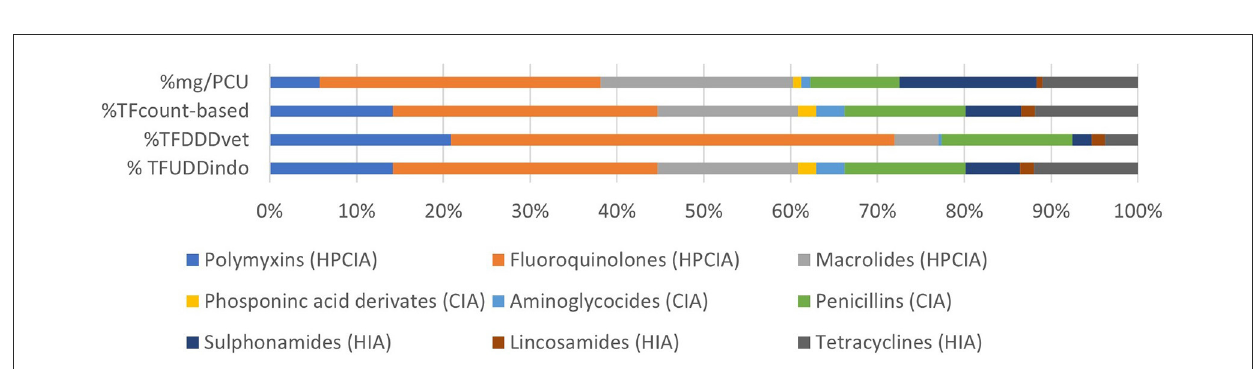
FIGURE2 Proportion of antimicrobial classes used in all monitored cycles using the four different AMU indicators.